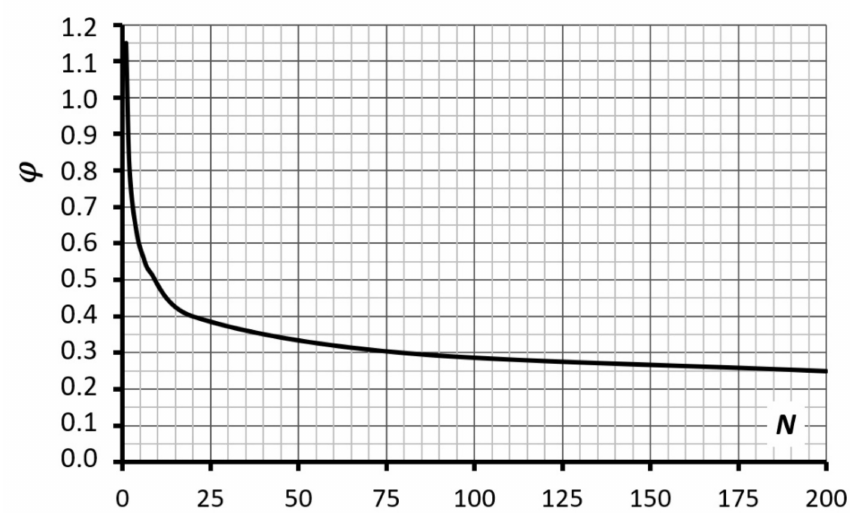
Figure 2. Value of coefficient of non-simultaneous consumption of hot water